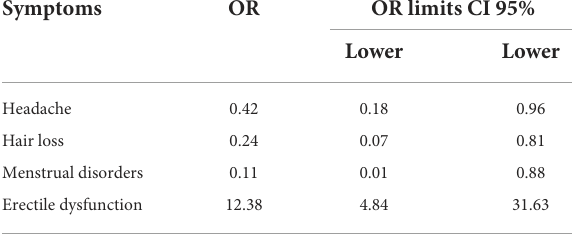
TABLE 4 Admission to ICU – symptoms of long